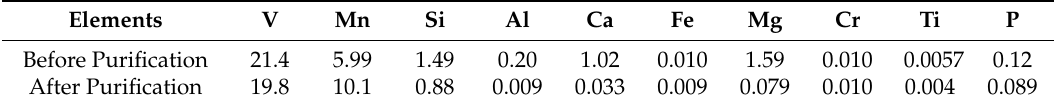
Table 1. Concentrations of V and main impurities contained in the of vanadium-bearing solution (g · L − 1 ). Elements